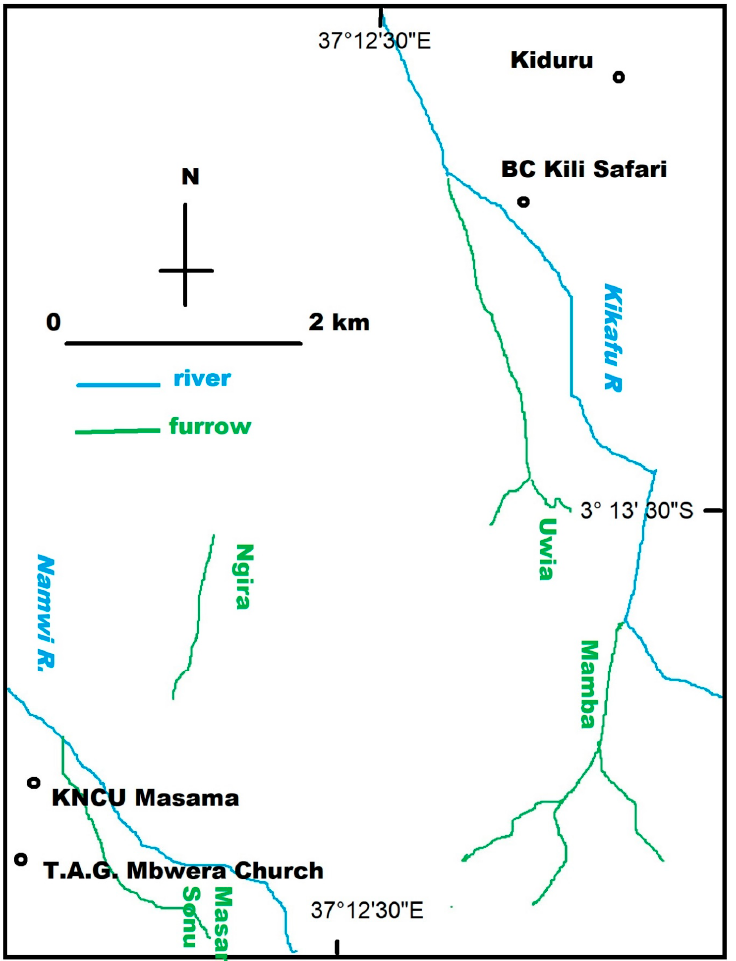
Figure 5. The distribution of furrows from Kikafu and other rivers, Machame (Prepared by the GIS Laboratory at Stella Maris Mutwara University College and modified by Innocent Pikirayi).